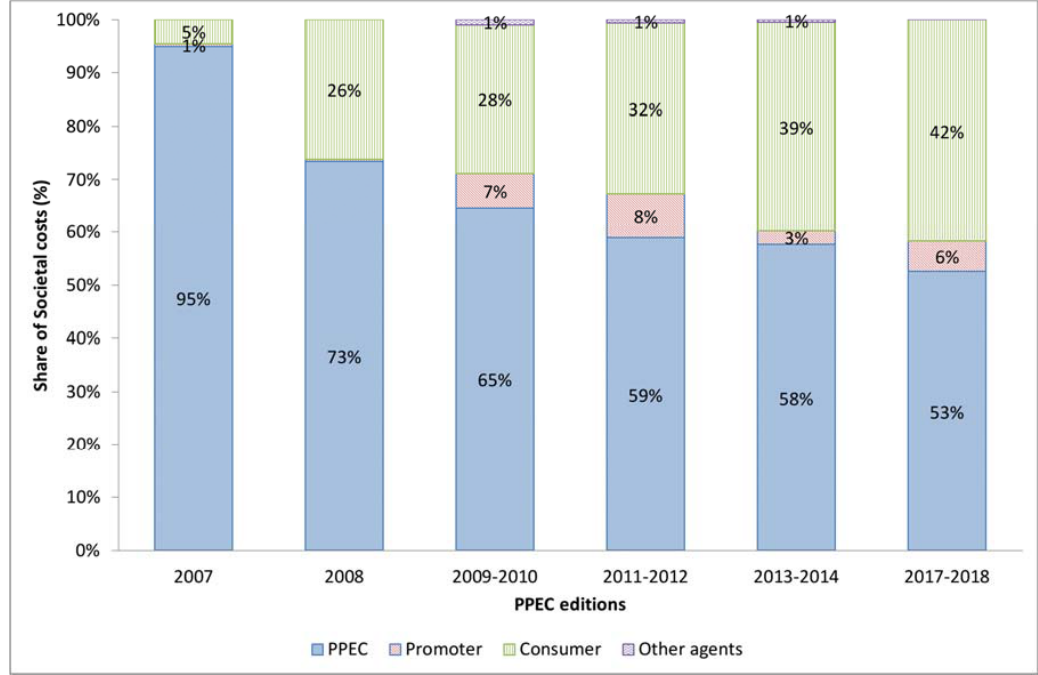
Figure 7. Share of societal costs of the eligible tangible measures in each PPEC edition [19–25].